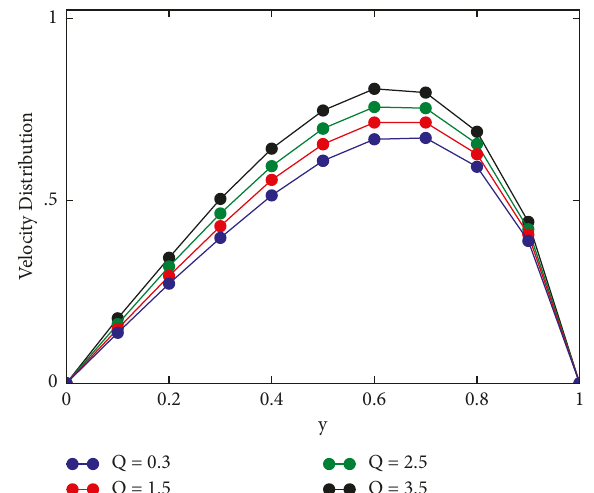
Figure 15: Effect of Magnetic field M on velocity after Pr